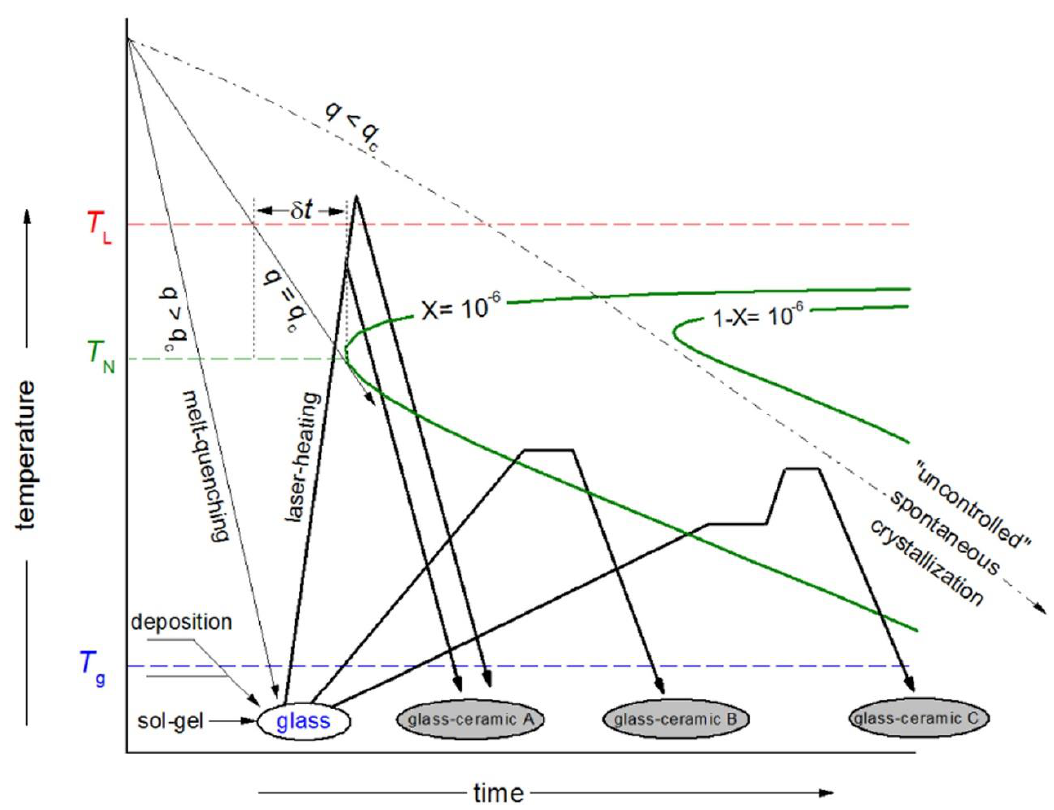
Figure 9. Schematic of conversion of glass into GCs. Reprinted with permission from Ref. [65].